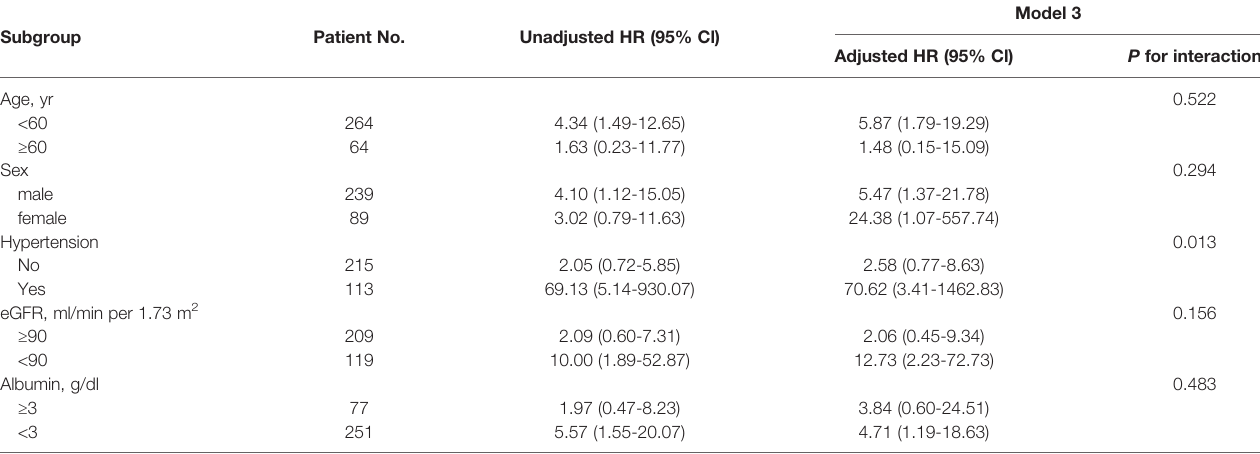
TABLE 7 | Subgroup analysis of the interactions of renal function progression event with age, sex, hypertension, level of baseline kidney function and baseline albumin using Cox proportional hazard model.